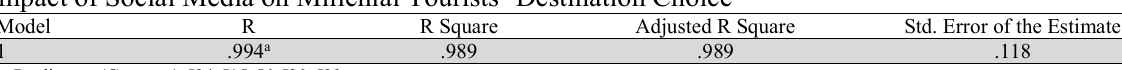
Impact of Social Media on Millenial Tourists’ Destination Choice